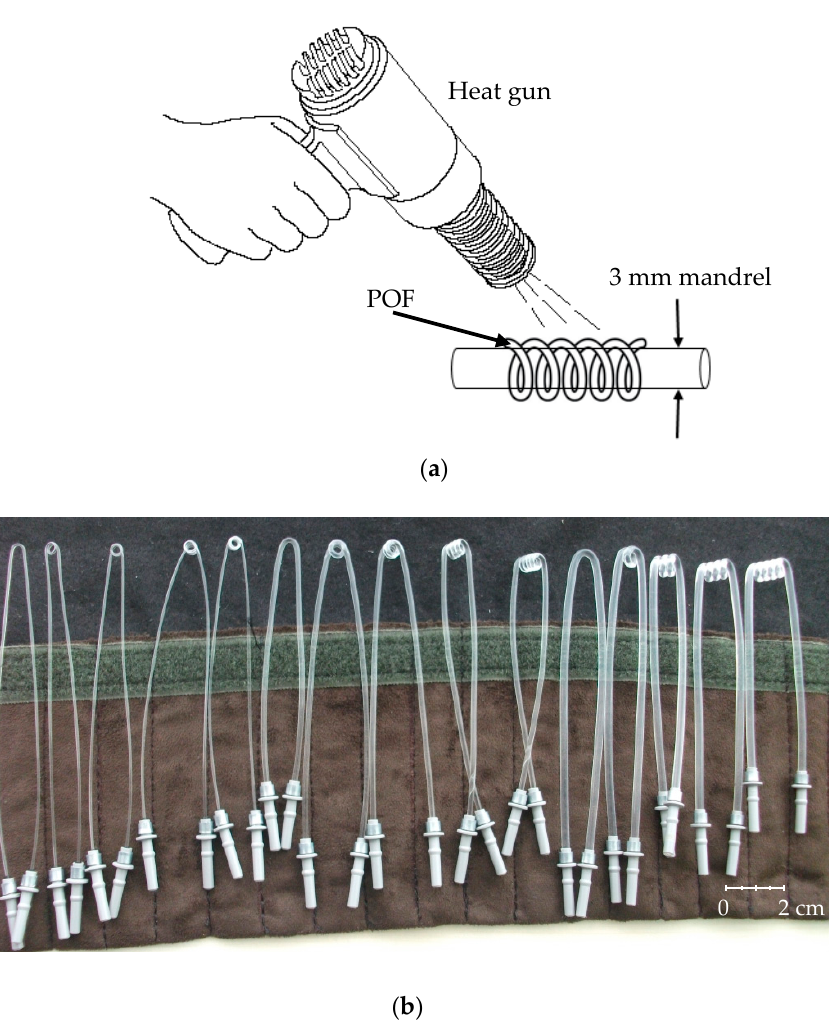
Figure 3. ( a ) Fabrication process of the probes; ( b ) Sensor probes.